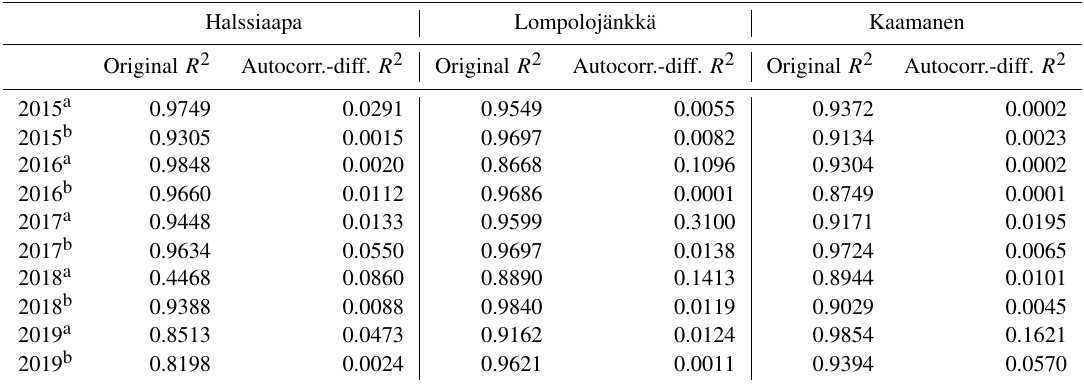
Figure 8. Development of GCC and GPP max from 1 May to 30 September in 2015–2019 at Lompolojänkkä. Different symbols and colours denote different years, and the bands show the 95% confidence intervals of the fitted double hyperbolic tangent function. The red dots indicate the fixed start and end days defined for the fitting. Table 5. The coefficient of determination ( R 2 ) of the linear regression between GCC and GPP max and of the regression after differencing the data for